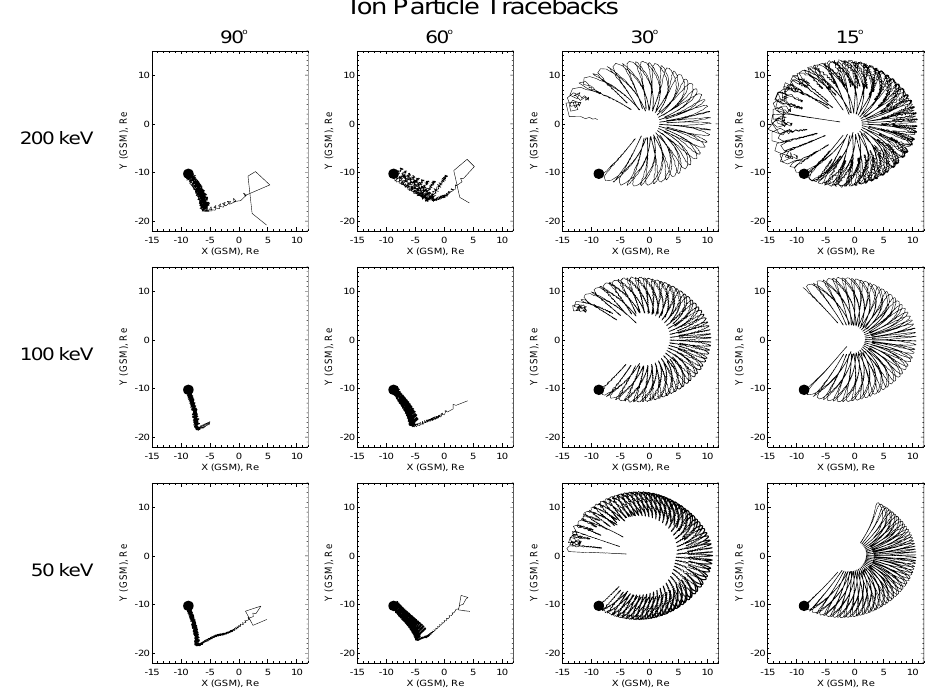
Fig. 13. TRAJGEN trace back of protons from the location of the ISEE-1 satellite at 10:00 UT on 3 March 1979. The trace backs are plotted in the GSM X-Y plane. The protons were plotted for four different pitch angles: 15 ◦ , 30 ◦ , 60 ◦ , and 90 ◦ and with three different energies: 50keV, 100keV, and